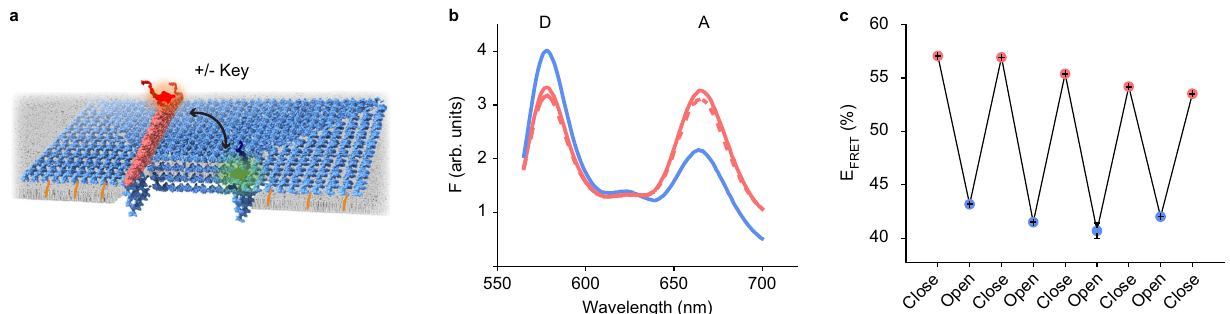
Fig. 3 Reversible gating by LGC. a Scheme showing LGC, containing donor dye on the plate (green) and acceptor dye on the lid (red). The addition of key and reverse key leads to respectively, opening and closing of the lid — resulting in closing or increasing the distance between the two dyes. b Representative fl uorescence spectra for one full cycle of lid opening-closing (D and A on the graph represent fl uorescence maxima for donor and acceptor respectively) and c FRET ef fi ciency corresponding to reversible gating of LGC lid over four full cycles; data points and error bars respectively represent average relative FRET ef fi ciency and standard deviation of the mean from n = 3 technical repeats. Initially, when the lid is closed, the spatial proximity of the donor and acceptor enables FRET, resulting in lower donor fl uorescence, higher acceptor fl uorescence ( b , solid pink), and high FRET ef fi ciency ( c , close, pink dots). Opening the lid using a key (dynamic-open) moves the donor and acceptors far from each other. Thus, FRET ceases, resulting in higher donor fl uorescence, lower acceptor fl uorescence ( b , solid blue) and lower FRET ef fi ciency ( c , open, blue dots). Closing the lid back from its open state using a reverse key (dynamic-closed) restores FRET, again resulting in lower donor fl uorescence, higher acceptor fl uorescence ( b , dashed pink), and high FRET ef fi ciency ( c , closed, pink dots). Source data are provided as a Source Data fi